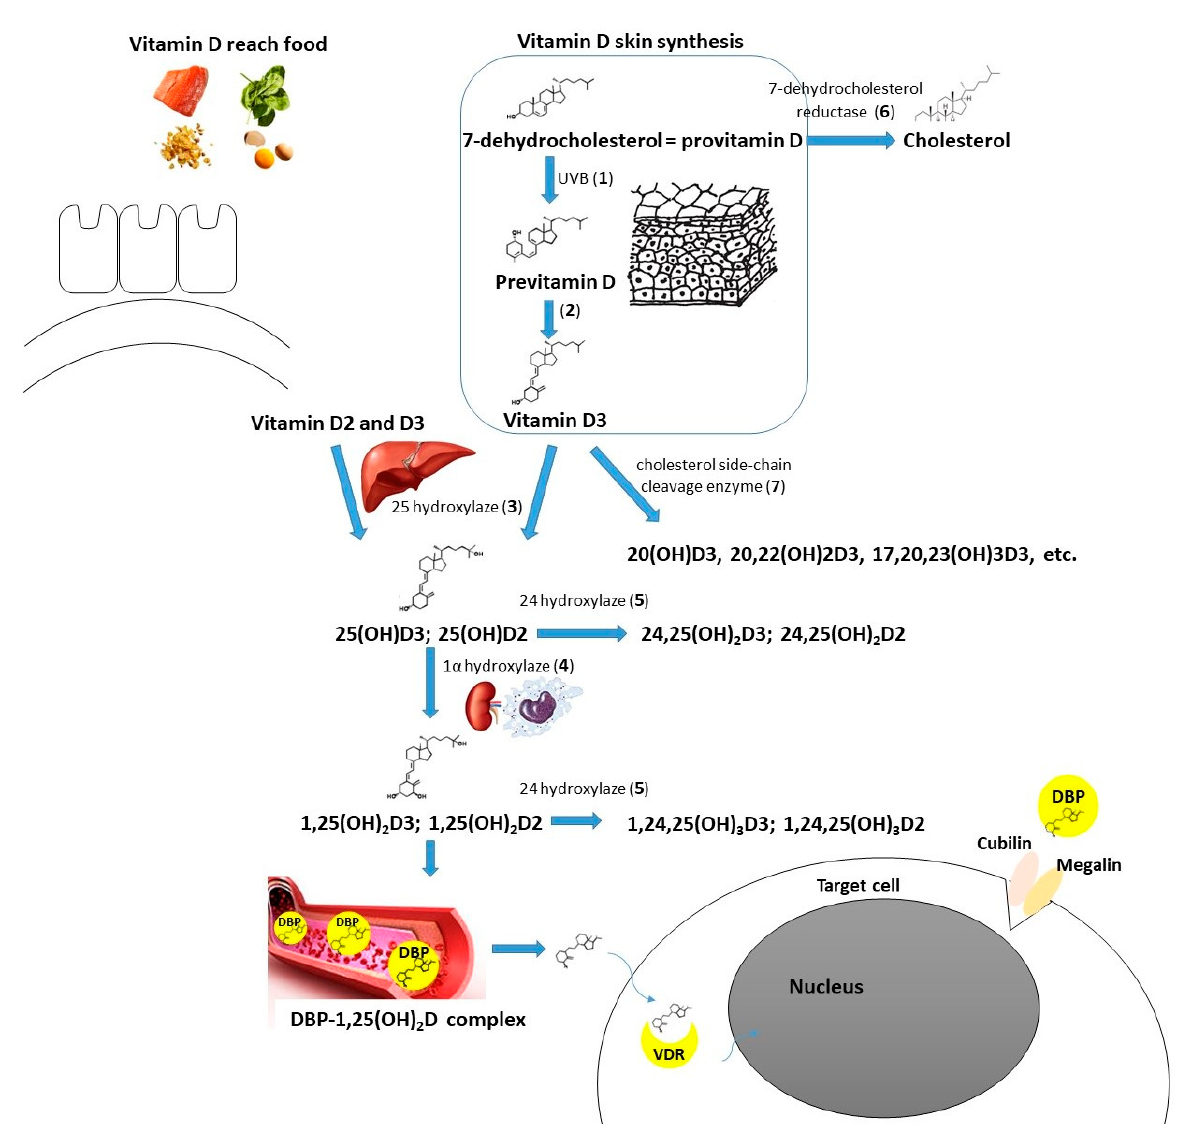
Figure 2. Vitamin D metabolism (including molecules/enzymes involved, coding genes in brackets): Cubilin ( CUBN ); DBP—vitamin D binding protein ( GC ); Megalin ( LRP2 ); VDR—vitamin D receptor ( VDR ); 1—UVB radiation, 290–315 mm wavelength; 2—nonenzymatic isomerization reaction under the temperature; 3—25-hydroxylase (main enzyme— CYP2R1 —cytochrome P450 family 2 subfamily R member 1, minor role of CYP27A1 —cytochrome P450 family 27 subfamily A member 1); 4—1 α -hydroxylase ( CYP27B1 —cytochrome P450 family 27 subfamily B member 1); 5—24-hydroxylase ( CYP24A1 —cytochrome P450 family 24 subfamily A member 1); 6—7-dehydrocholesterol reductase ( DHCR7 ); 7—cholesterol side-chain cleavage enzyme ( CYP11A1— cytochrome P450 family 11 subfamily A member 1).